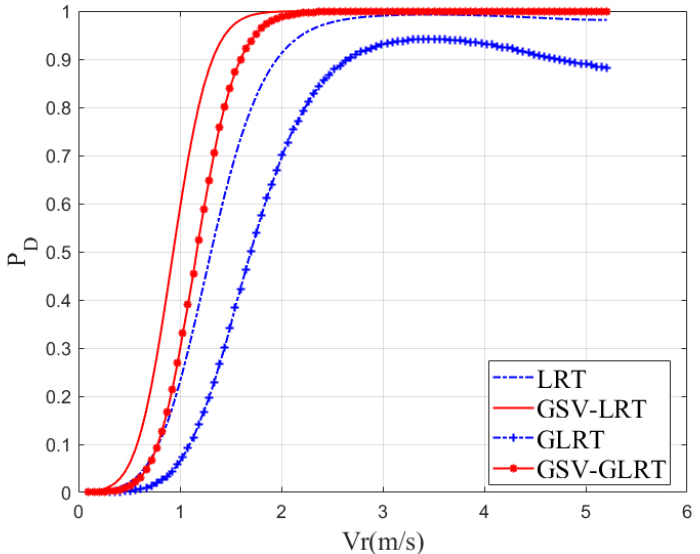
Figure 5. Detection probability versus velocity, SCR = − 5 dB, CNR = 13 dB, P FA = 10 − 4 , three channels, b1 = 0 m, b2 = 0.15 m, b3 = 0.3 m, β = [ 0.6,0.6,1,0.2,0.2 ] T ⊗ 1 3